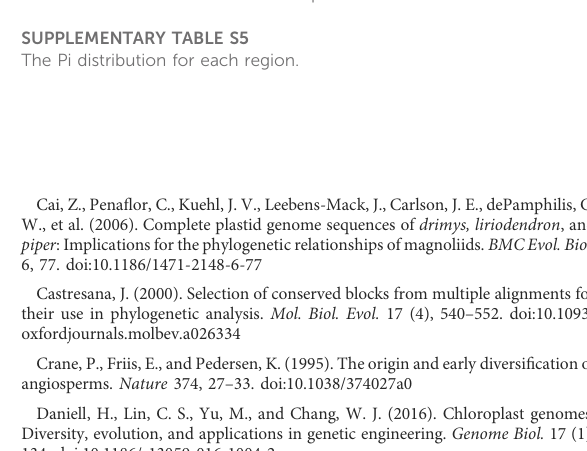
SUPPLEMENTARY FIGURE S1 The gene map of eight Piper chloroplast genomes. SUPPLEMENTARY FIGURE S2 The bar chart of the number of nucleotide substitutions. SUPPLEMENTARY FIGURE S3 The phylogenetic tree obtained from the sequences of different regions. SUPPLEMENTARY TABLE S1 The basic information of each chloroplast genomes. SUPPLEMENTARY TABLE S2 The information of SSR in eight Piper species. SUPPLEMENTARY TABLE S3 The information of SNP between species. SUPPLEMENTARY TABLE S4 The information of indels between species. SUPPLEMENTARY TABLE S5 The Pi distribution for each